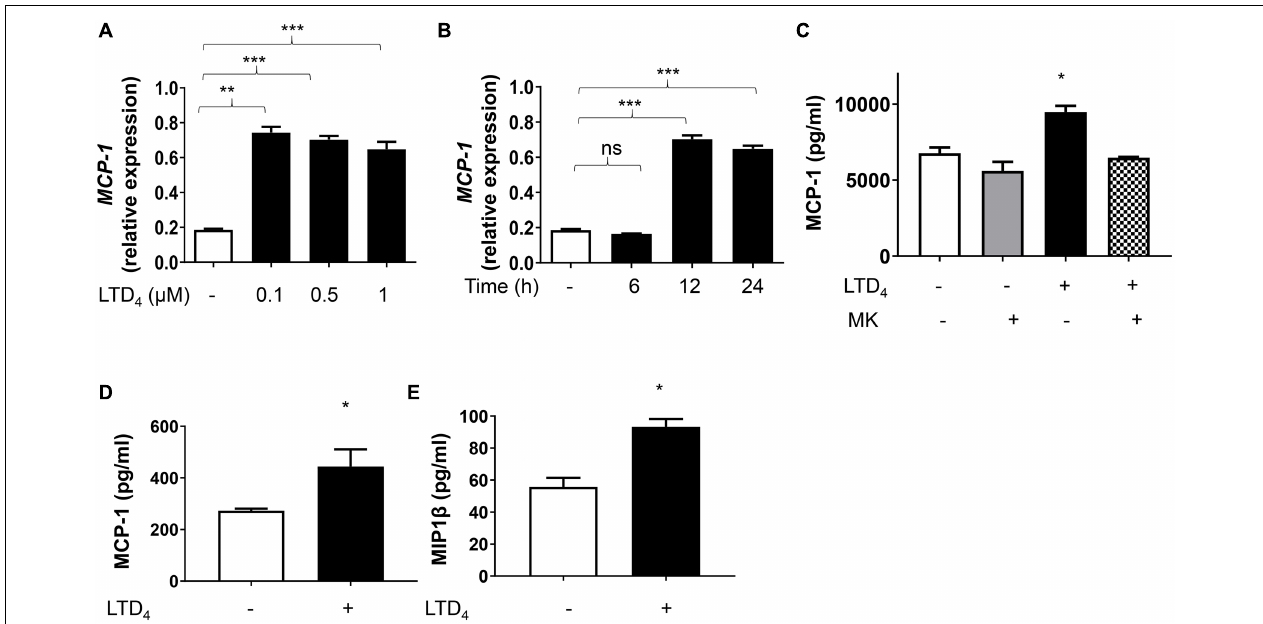
FIGURE 6 | CysLTs enhance MCP-1 production in macrophages. Raw macrophages were treated with increasing concentrations of LTD 4 (A) , for 6, 12, and 24 h (B) , and MCP-1 transcript was analyzed using qPCR. In panel (C) , raw macrophages were pre-incubated for 30 min in the presence or absence of MK571, treated with 0.5 µ M LTD 4 for 6 h and supernatants were collected and analyzed for MCP-1. BMDMs (D,E) were treated with 0.5 µ M LTD 4 for 6 h, supernatants were collected and (D) MCP-1 protein and (E) MIP1 β protein in the supernatants were analyzed by ELISA according to the manufacturer’s instructions. The results shown are mean ± SEM from three experiments (one-way ANOVA followed by post hoc Tukey multiple comparison test, * p ≤ 0.05, ** p ≤ 0.01 *** p ≤ 0.001, ns = not significant).